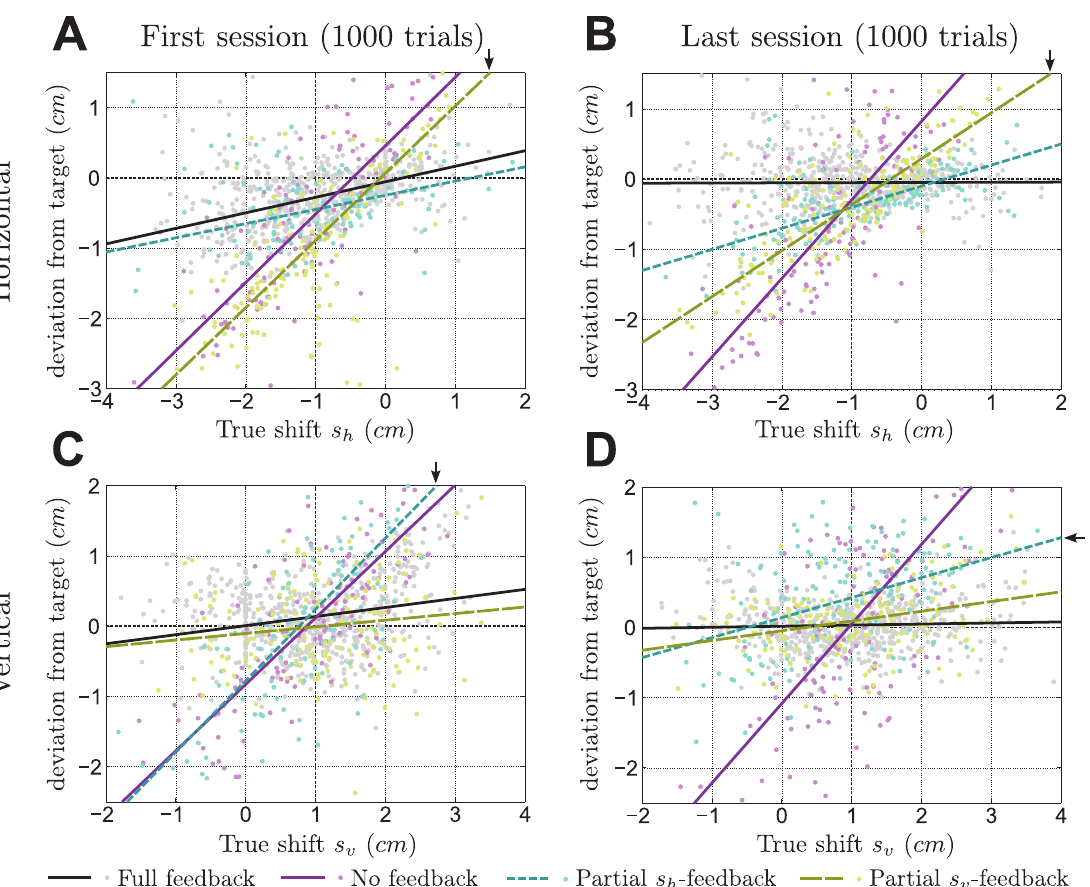
Fig 3. Data of a typical participant (no. 6, correlated group). The plots show the deviation of the final virtual hand position from the target as a function of the true shift. Dots represent individual trials and the lines show robust fits through the corresponding dots. Different colors indicate different feedback conditions. The crossing of the black dashed lines indicates the optimal pivot-point. Top row A,B : horizontal deviation as a function of the horizontal shift s h . Bottom row C,D : vertical deviation as a function of the vertical shift s v . The left column A,C shows results recorded in the first session of the experiment, the right column B,D shows results from the last session. In early trials, the participant ’ s reaction to partial feedback trials in the noninformative dimension is very similar to behavior in no-feedback trials. Importantly, across sessions there is a significant reduction in slope in the noninformative dimension of the partial feedback trials, indicating learning of the correlation structure (compare changes in lines highlighted with arrows, that is the yellow dashed lines in panels A and B and cyan dashed lines in panels C and D).